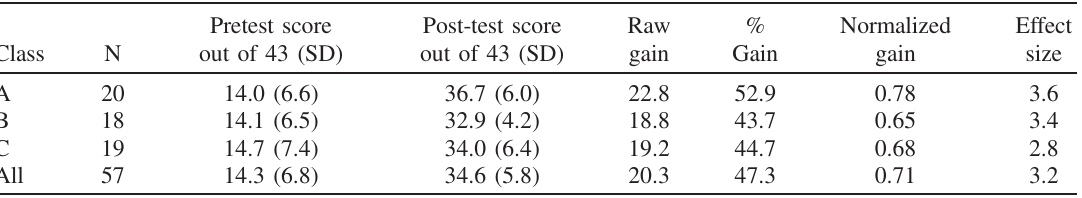
TABLE II. Comparison of mean scores between pretest and post-test (Spring 2014).